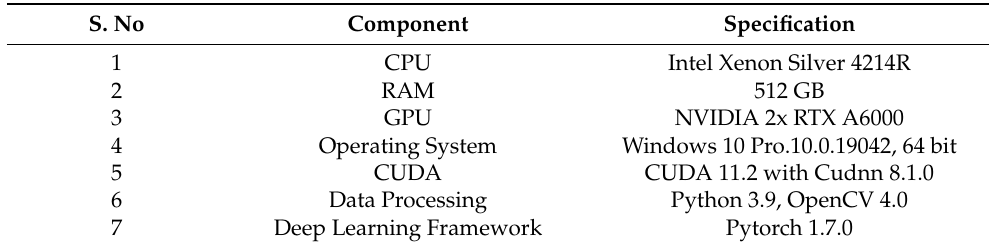
Table 1. Experimental hardware and software